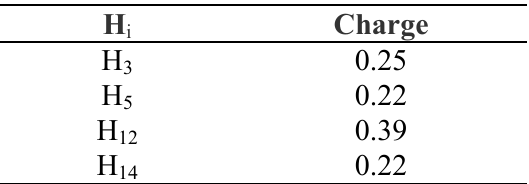
Table 3. NBO charge of the acidic protons of the compound 5c calculated at the DFT/B LYP level of theory. 3